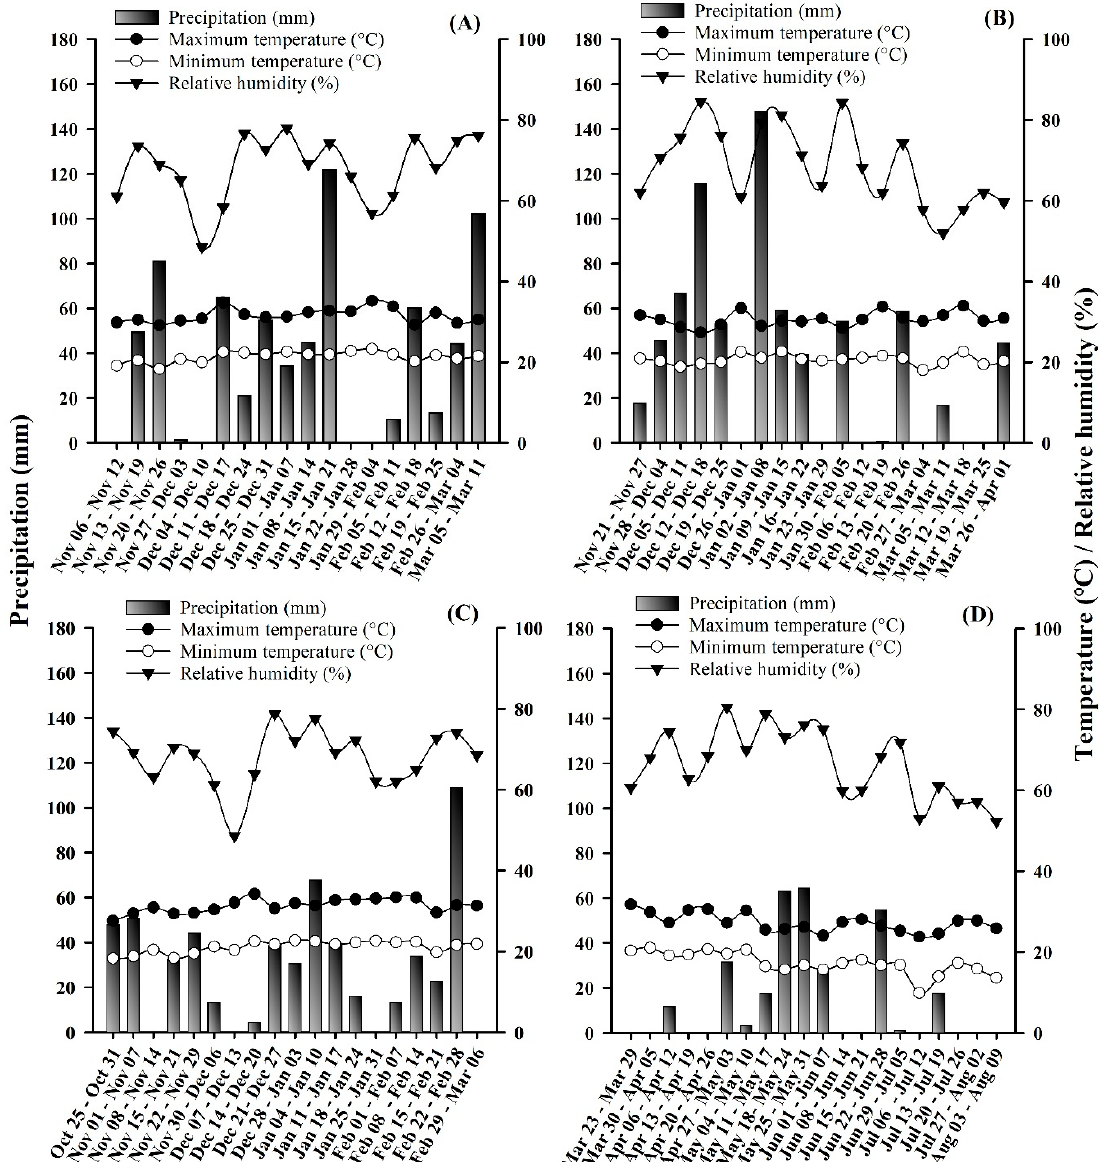
Figure 1. Precipitation, minimum and maximum temperature, and relative humidity of the air for soybean season 2018 / 2019 ( A ), soybean season 2019 / 2020 ( B ), corn first season 2018 / 2019 ( C ), and corn second season 2019 ( D